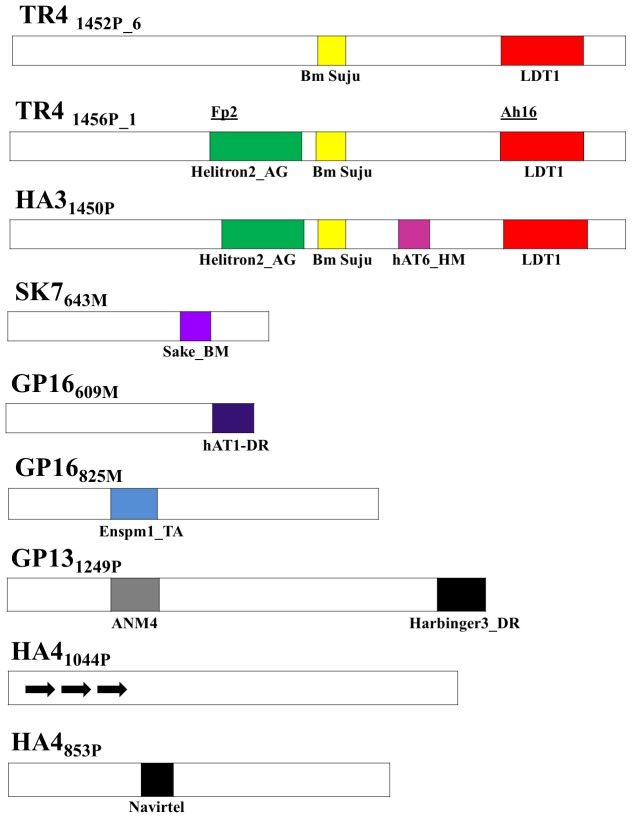
A map showing positions of motifs resembling putative transposable elements (boxes shown in different colors) within sequenced ISSR amplicons.Abbreviations are as described in Table 2. Arrows denote tandem repeats. The bold lines ( ) indicate position of nested primers (Fp2 and Ah16) within amplicon EU872512.